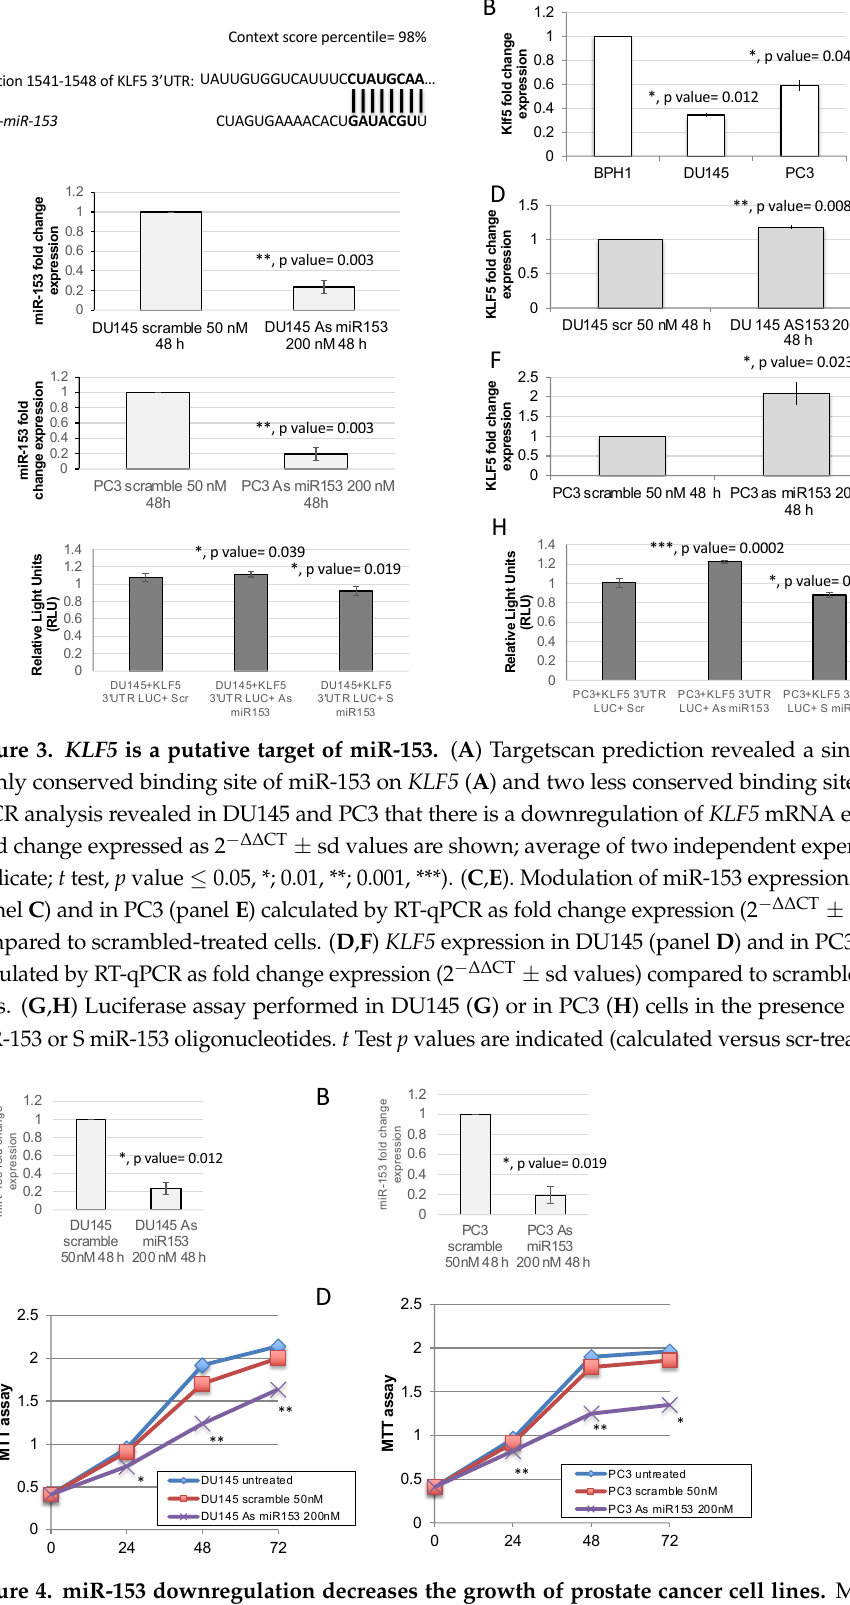
Figure 4. miR-153 downregulation decreases the growth of prostate cancer cell lines. MTT assay revealed that the modulation of miR-153 expression, obtained by 200 nM of antisense (As) oligonu- cleotide treatment and revealed by RTqPCR (fold change expression, as 2 − ∆∆ CT ± sd values), in DU145 ( A ) and PC3 ( B ) cell lines decreased cell growth in both cell lines ( C , D ), respectively). Summary of two experiments in triplicate ( t test compared to scramble treated cells, p value ≤ 0.05, *; 0.01,